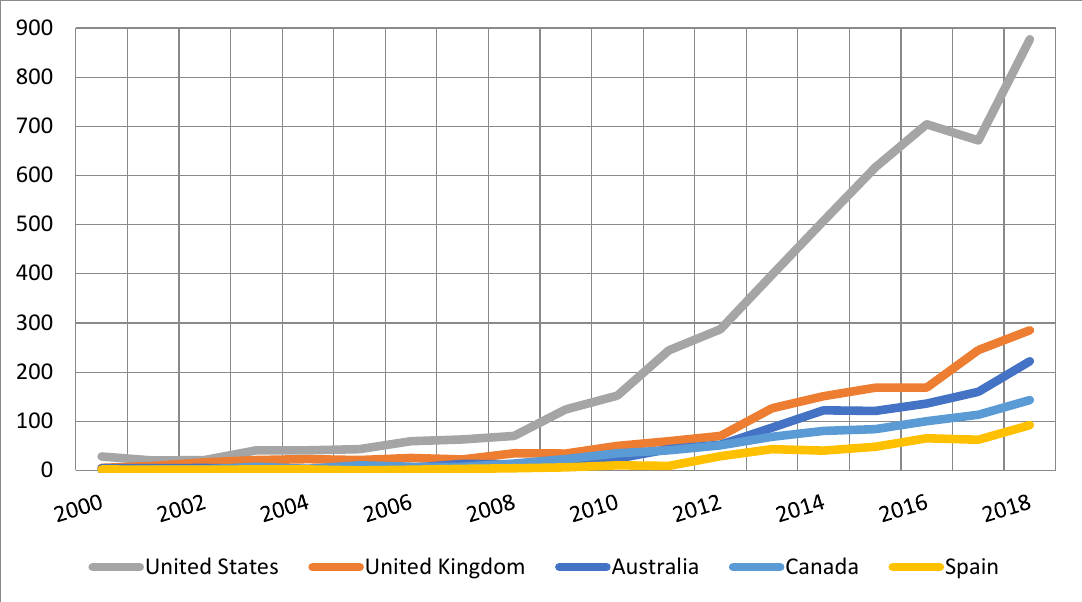
Figure 6. The trend of publications in the five countries with higher rates during the period of 1978 – 2018.